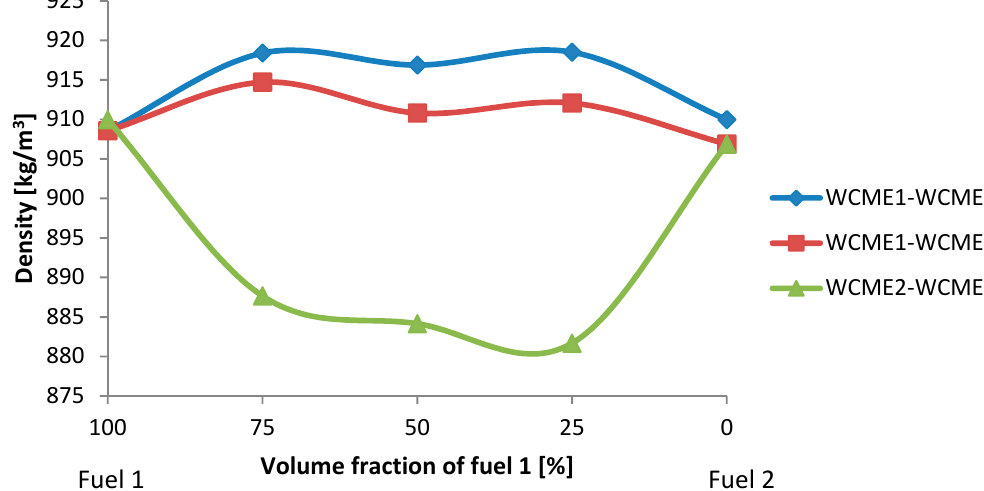
Figure 6. Density versus volume fraction at the temperature of 15 ◦ C (WCME1-WCME2: WCME 1 and WCME2 are considered as fuel 1 and fuel 2; WCME1-WCME3: WCME 1 and WCME3 are considered as fuel 1 and fuel 2; WCME2-WCME3: WCME 2 and WCME3 are considered as fuel 1 and fuel 2).